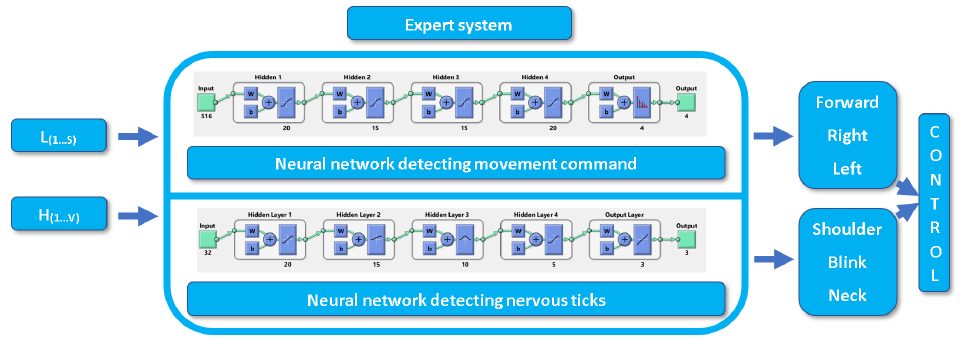
Figure 15. Expert system based on two neural